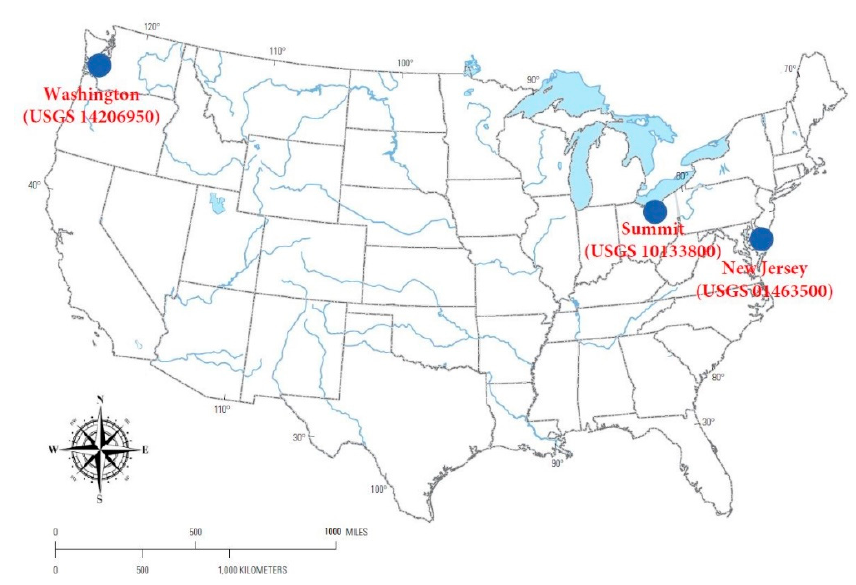
Figure 3. The locations of the three case study sites in Washington (USGS 14206950), Summit (USGS 10133800), and New Jersey (USGS 01463500), USA.